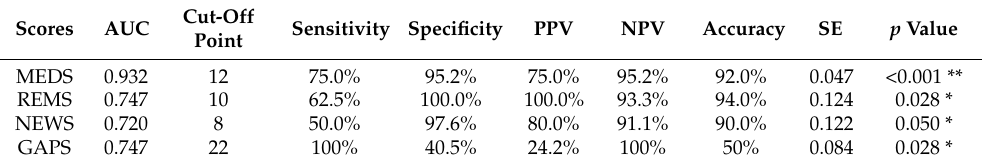
Table 8. The AUC of ROC, cut-off point, sensitivity specificity, positive predictive value (PPV), negative predictive value (NPV), accuracy, and standard error (SE) of MEDS, NEWS, REMS, and GAPS to predict the mortality risk.